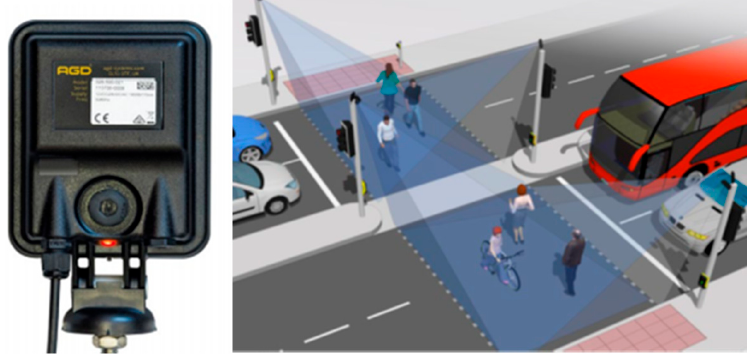
Figure 2. The AGD326 radar is a 24 GHz pedestrian detector can be used for crossing phase optimi- zation. (Image source: www.agd-systems.com; accessed on 30 October 2021). optimization. (Image source: www.agd-systems.com; accessed on 30 October